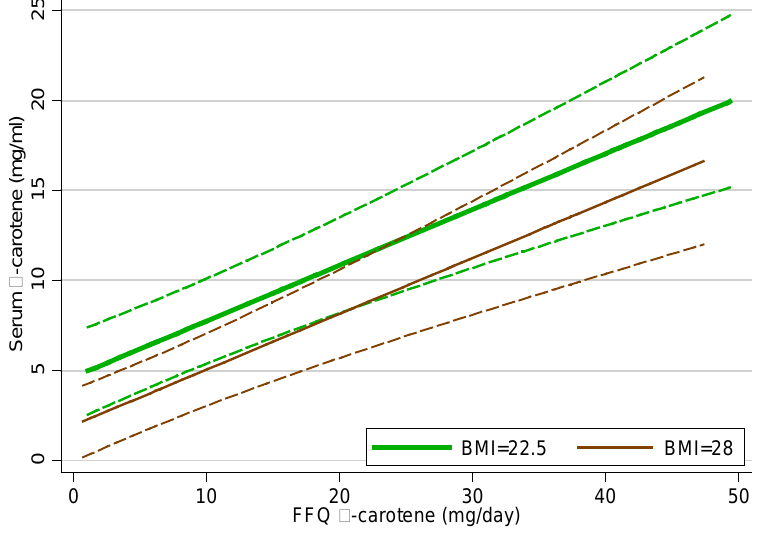
Figure 1. Estimated mean plasma α-carotene from multivariate linear regression model on FFQ α-carotene by BMI status, with 95% confidence interval. BMI = 22.5 and BMI = 28 were selected as these were the median BMI for the groups used in descriptive statistics shown Table